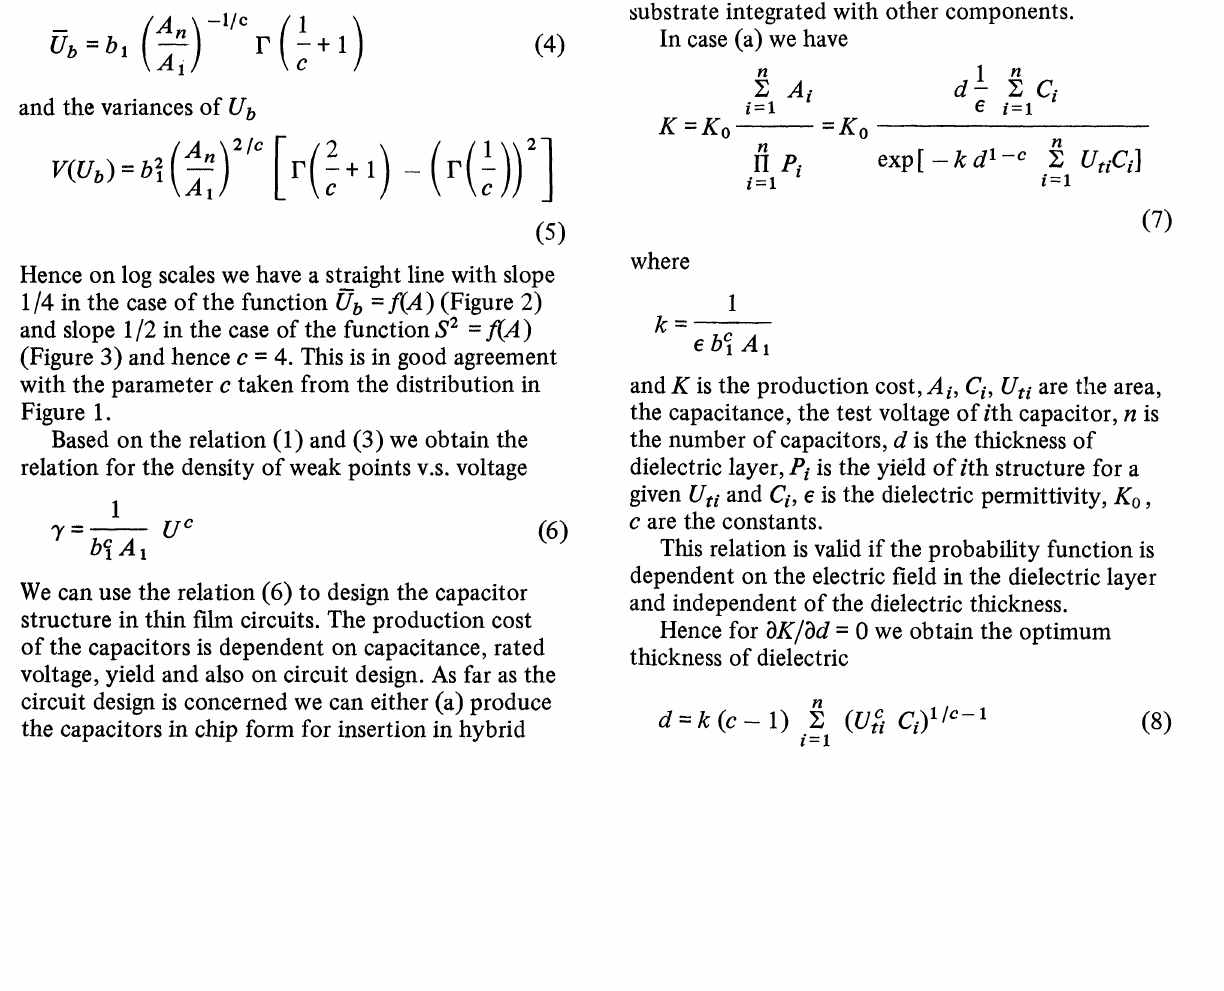
circuits or (b) make capacitors on the common substrate integrated with other